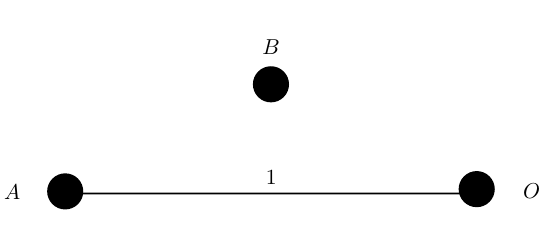
Figure 8 . An example of an extremal ray for N = 2 . The three entropy constraints consist of I ( A : B ) ≥ 0 , I ( A : O ) ≥ 0 , I ( B : O ) ≥ 0 . For this state I ( A : B ) = I ( B : O ) = 0 , I ( A : O ) = 2